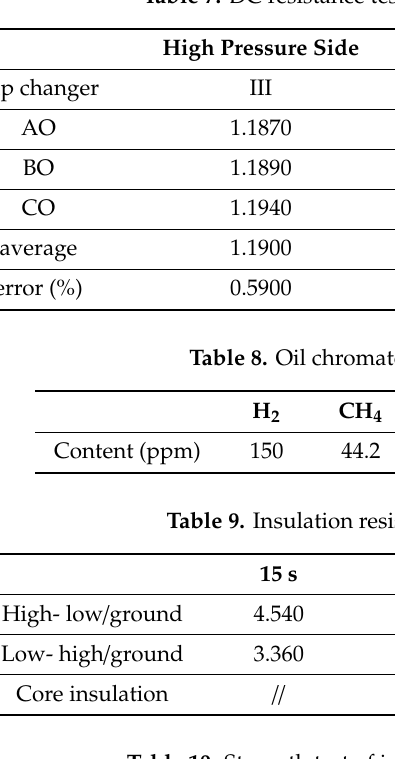
Table 10. Strength test of insulating oil and gas.